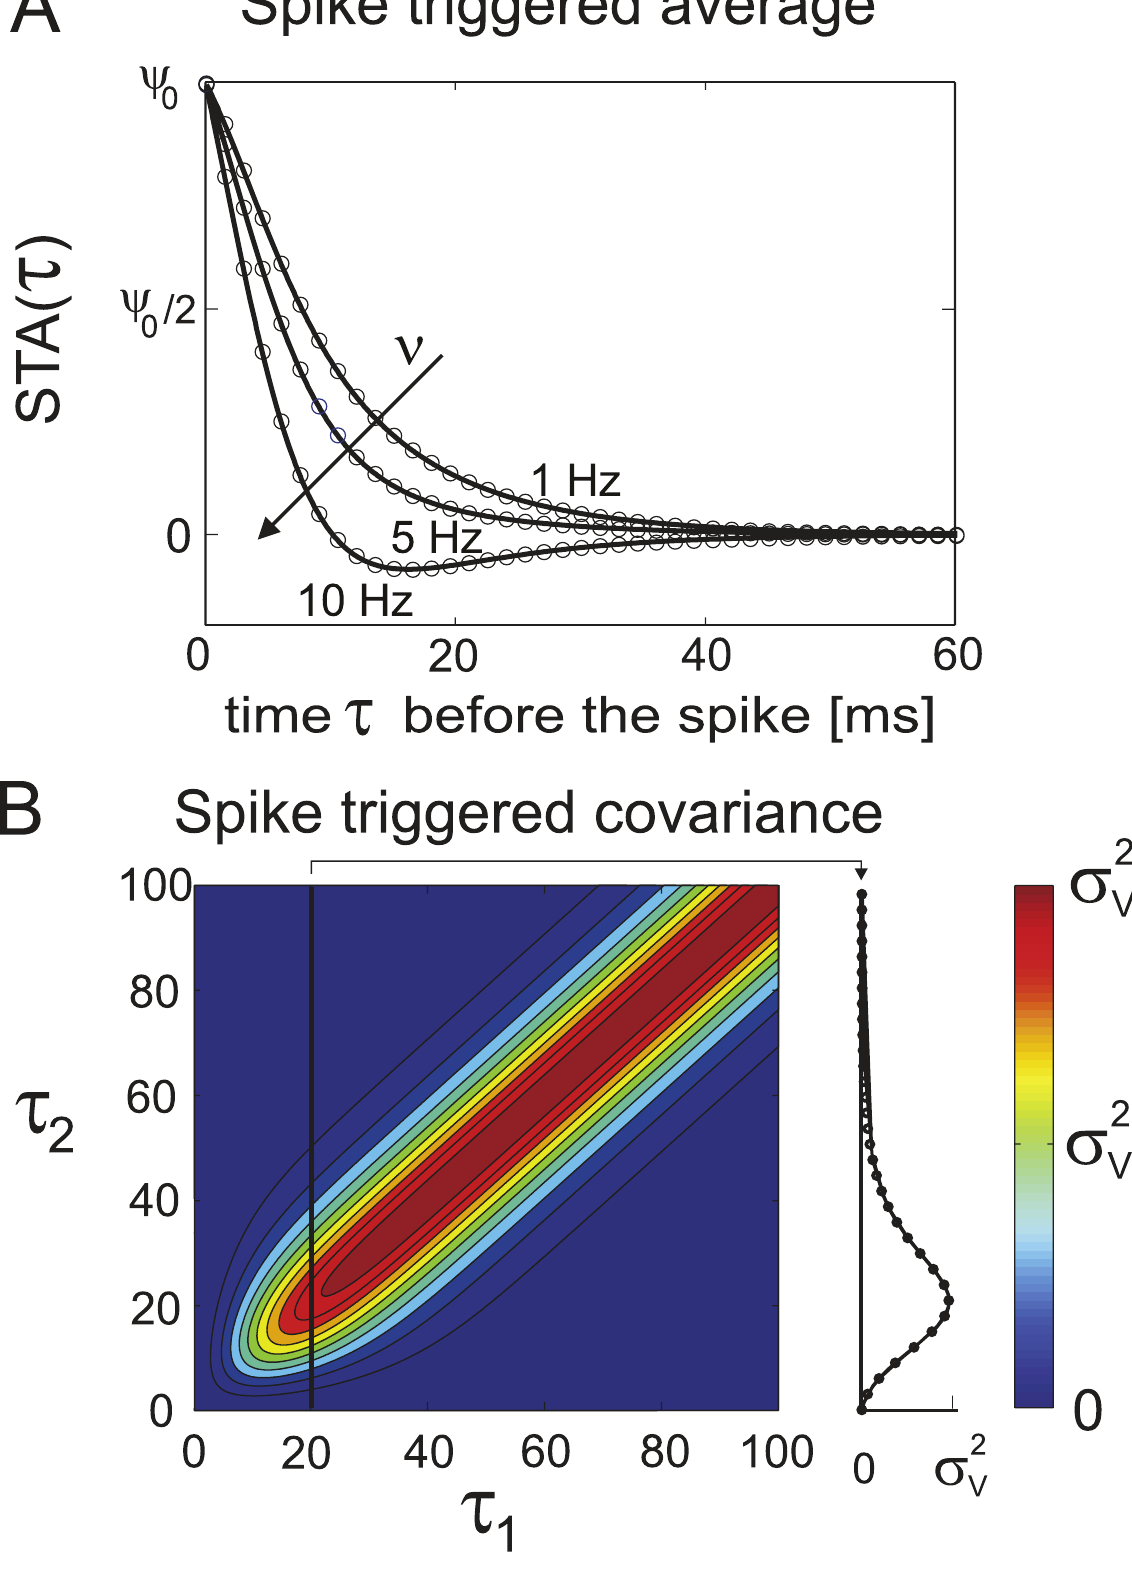
Figure 8. Statistics of spike triggering events in the threshold neurons. (A) Spike triggered average voltage STA ( t ) for t s ~ 10ms and firing rates n ~ 1,5,10Hz ; simulated results (circles) and analytical solution in Eq. 37 (solid lines). (B) Spike triggered voltage covariance STC ( t 1 , t 2 ) for n ~ 5Hz , t s ~ 10ms , the cross section STC (20ms, t 2 ) is shown at the right. Simulated results (circles) and analytical solution in Eq. 39 (solid lines). The solid vertical black line indicates t 1 ~ 20ms . doi:10.1371/journal.pcbi.1002239.g008 PLoS Computational Biology |